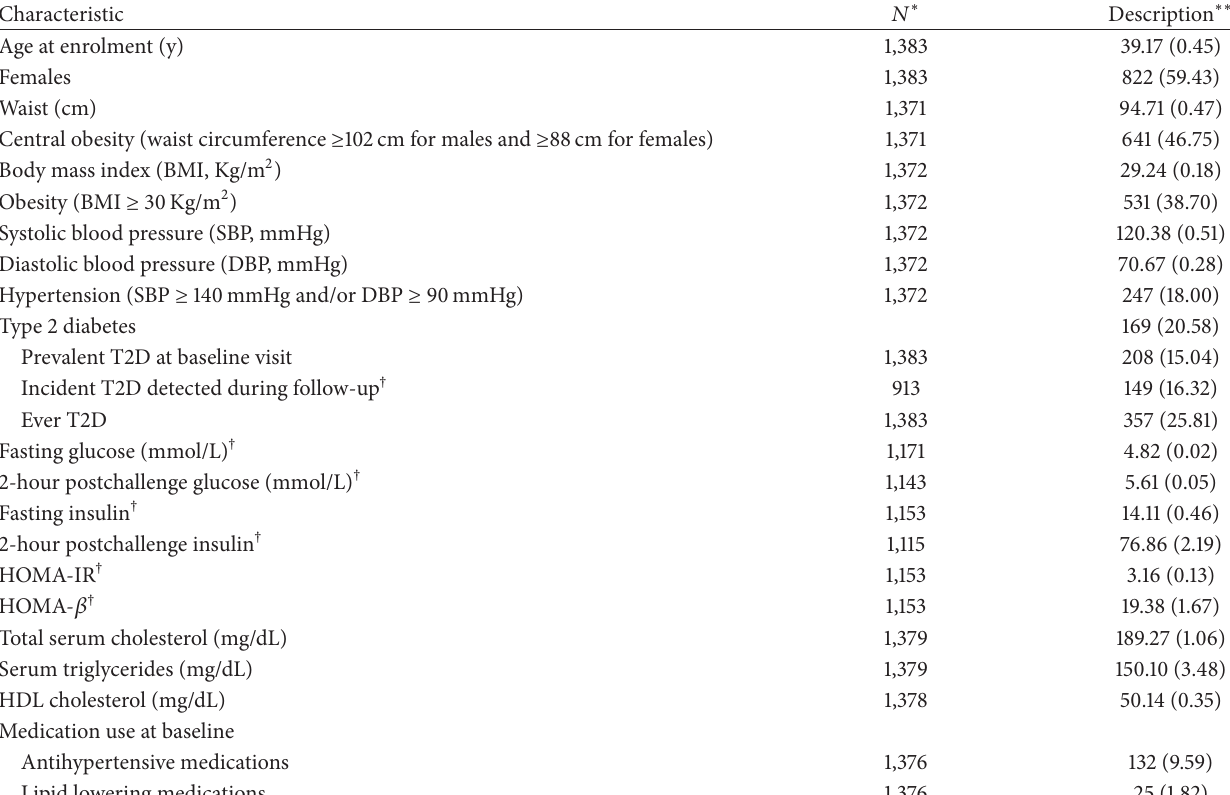
Table 1: Clinical characteristics of the SAFHS included in this study ( 𝑛 = 1, 383